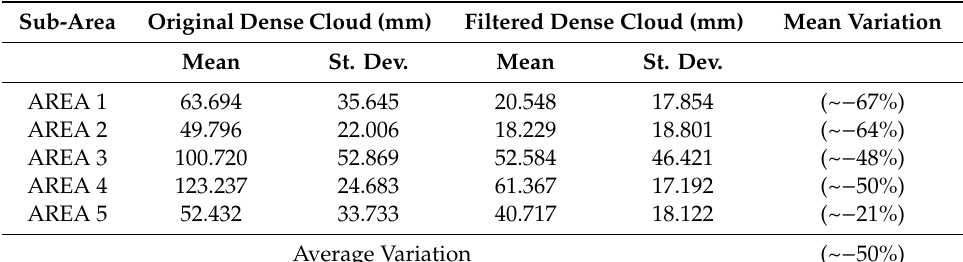
Figure 13. Selected five areas for cloud-to-cloud distance analyses and comparisons. Table 14. Cloud-to-cloud distance analysis on the original and filtered dense cloud and average variation of the mean values.